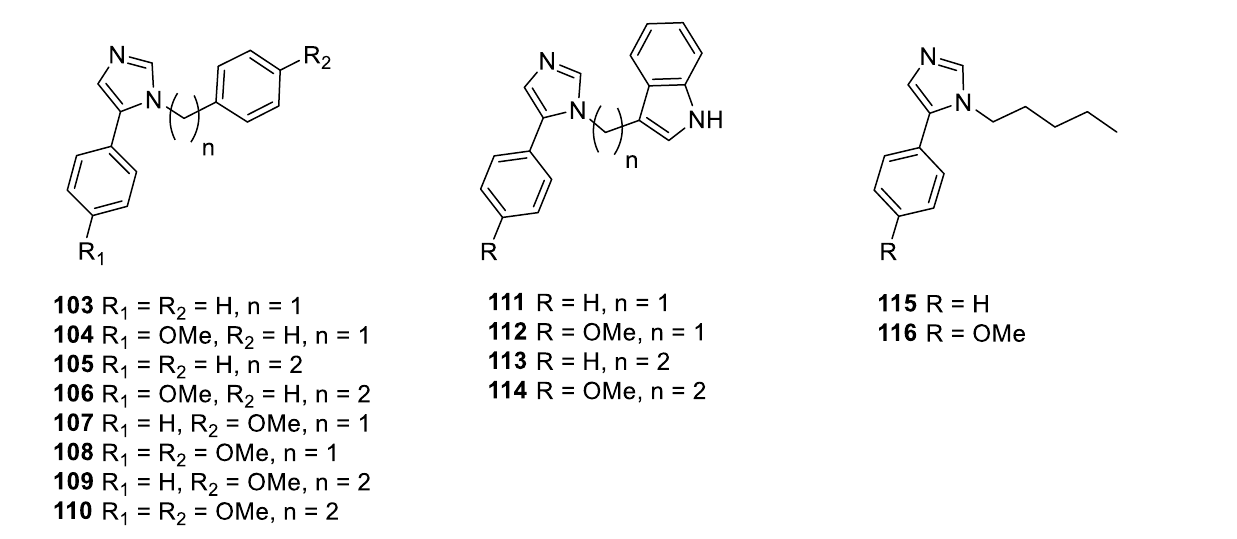
Figure 4. Structures of substituted 5-phenyl-1 H -imidazoles 103 – 116 .